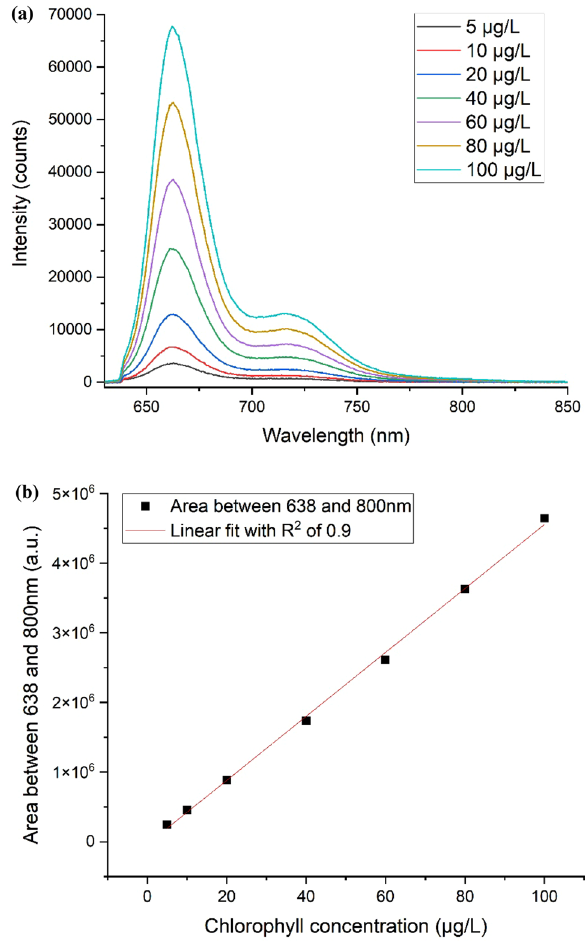
Figure 3. Shows the light-induced chlorophyll fluorescence spectra when excited with a 405 nm LED. ( a ) The LICF spectra of various chlorophyll concentrations in methanol. ( b ) The plot shows the linear relationship between chlorophyll fluorescence (fluorescence area) and chlorophyll